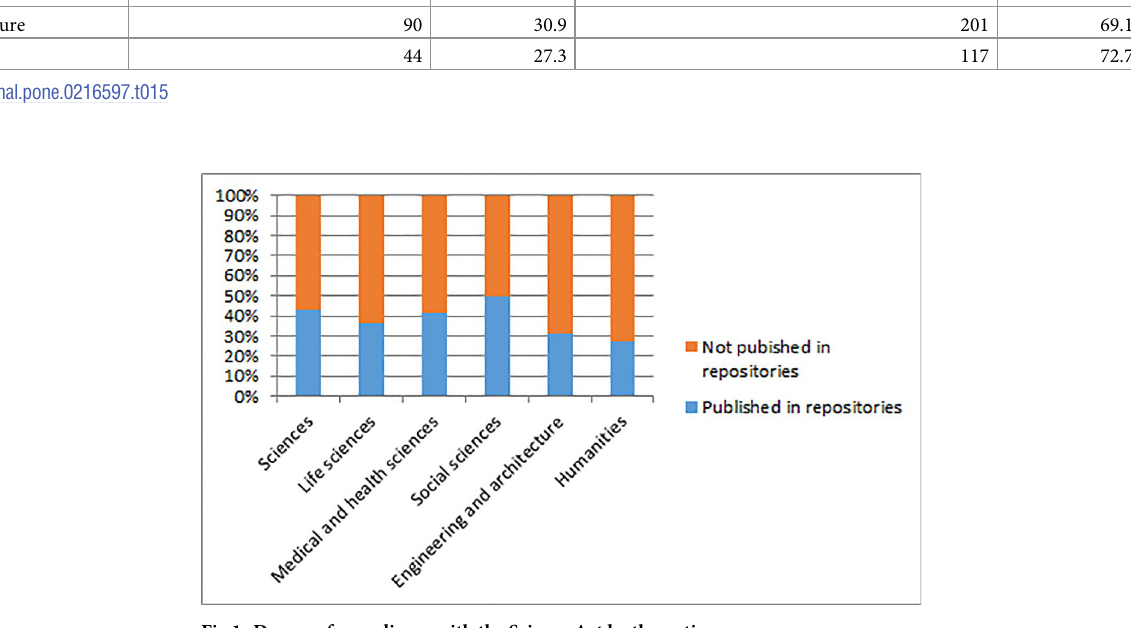
Fig 1. Degree of compliance with the Science Act by thematic